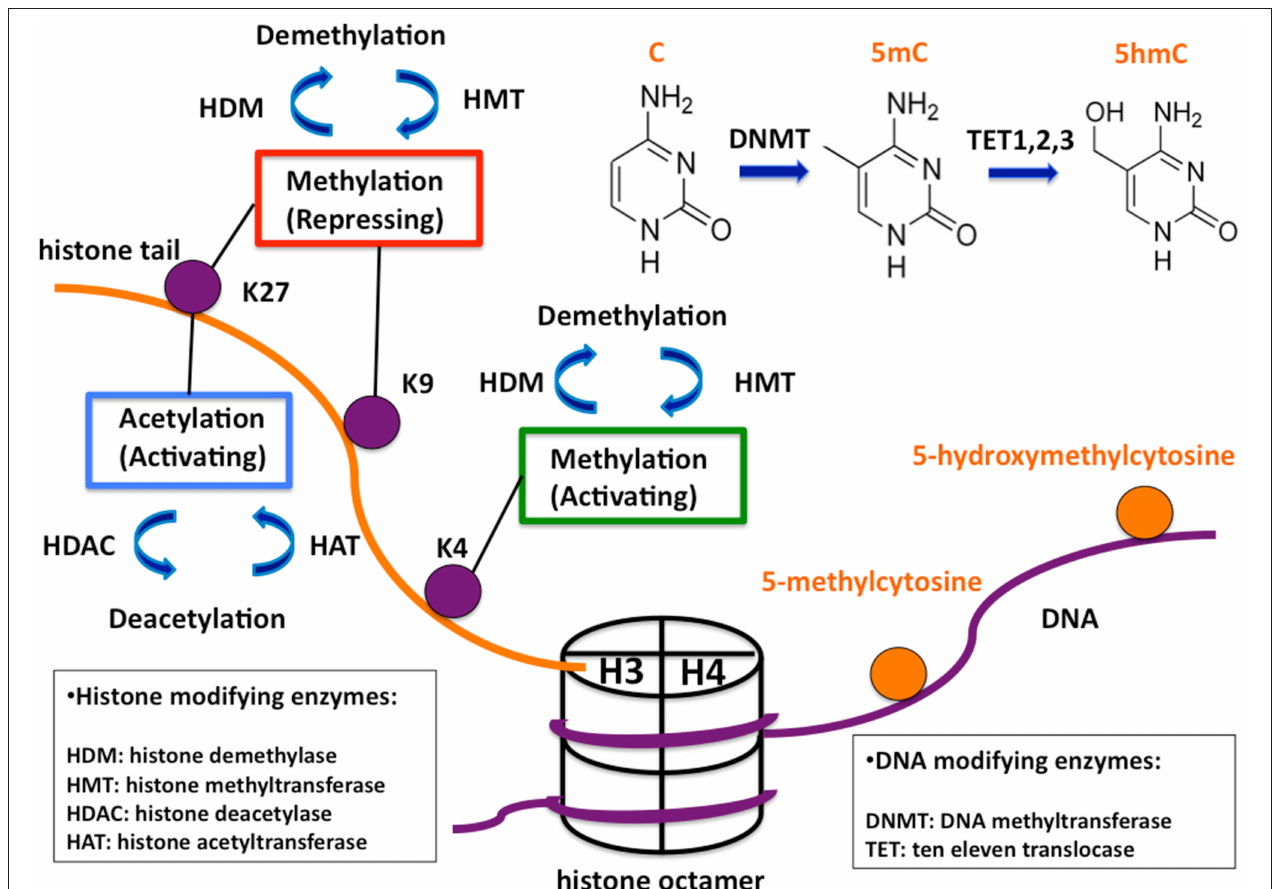
FIGURE 1 | Overview of common covalent epigenetic modifications. A schematic nucleosome and examples of potential epigenetic modifications are shown. The histone octamer is represented in a cylindrical form with one pair of histones H3/H4 indicated. The protruding H3 histone tail and DNA are indicated in orange and purple, respectively. Oppositely, histone and DNA modifications are shown in purple and orange. The functional roles of histone modifications are indicated in colored boxes. The enzyme families catalyzing the modifications are listed in boxes below. The enzymatic links between the different cytosine modifications are shown in the upper right corner of the